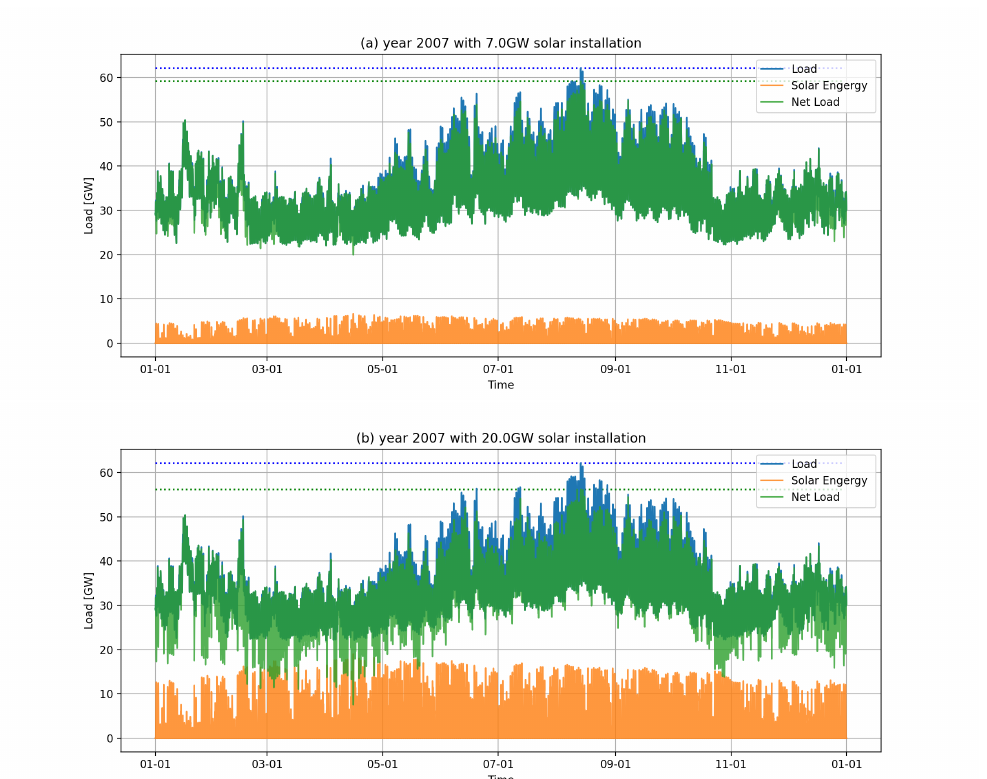
Figure 14. Effective renewable relief of installation of solar in 2007 with ( a ) 7 GW solar installation, and ( b ) 20 GW solar installation.